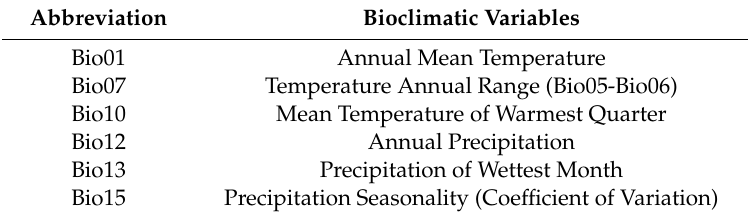
Table 1. Six bioclimatic variables from the WorldClim database that were retained after preliminary